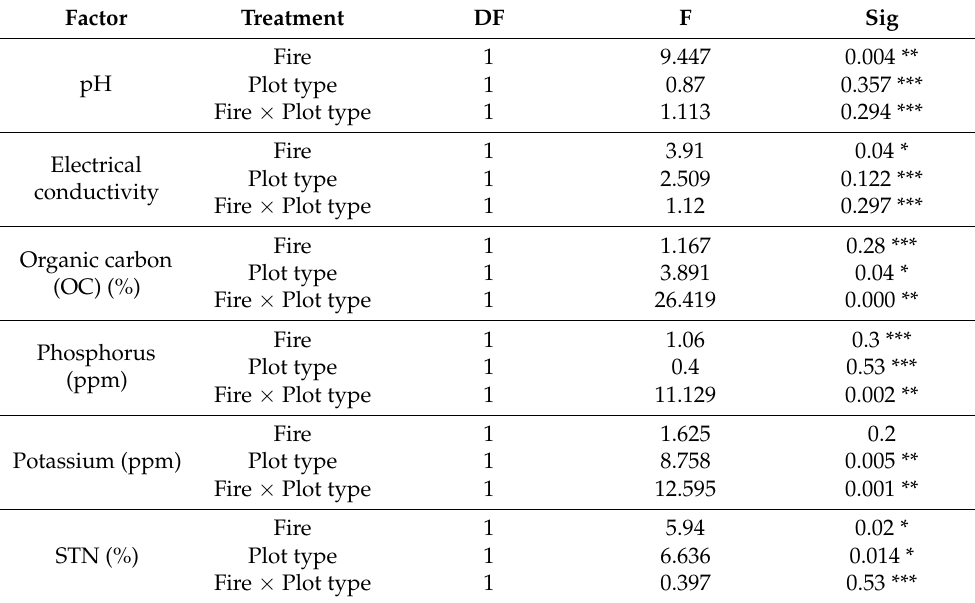
Table 4. Two-way analysis of variance of soil chemical properties in fire and non-fire treatments.